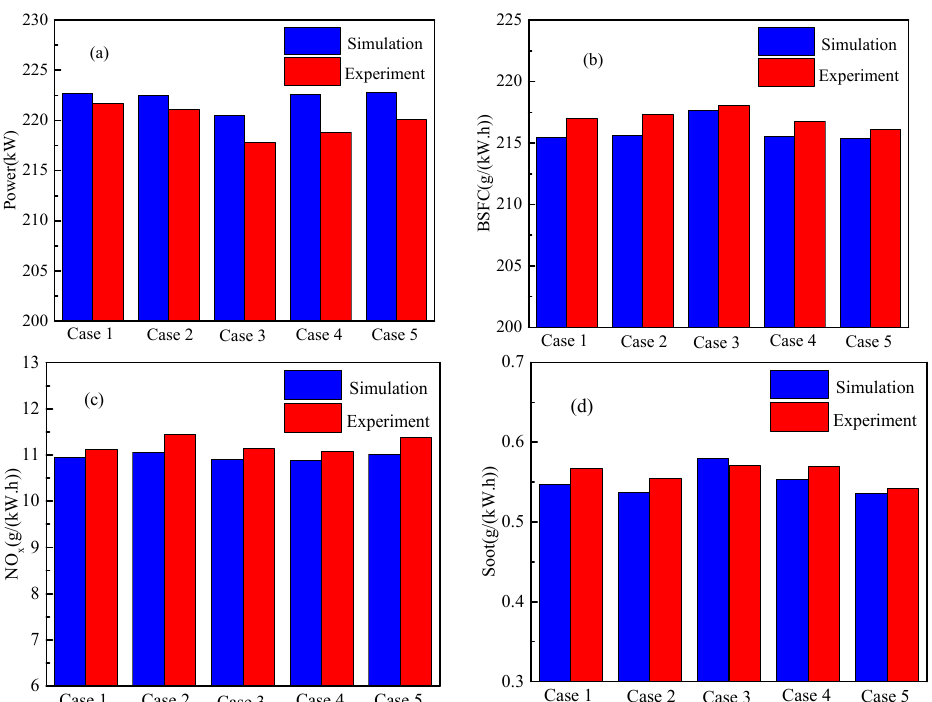
Figure 9. Comparison of the simulation results with constant fuel injection mass. ( a ) Power; ( b ) BSCF; ( c ) NOx; ( d ) Soot.